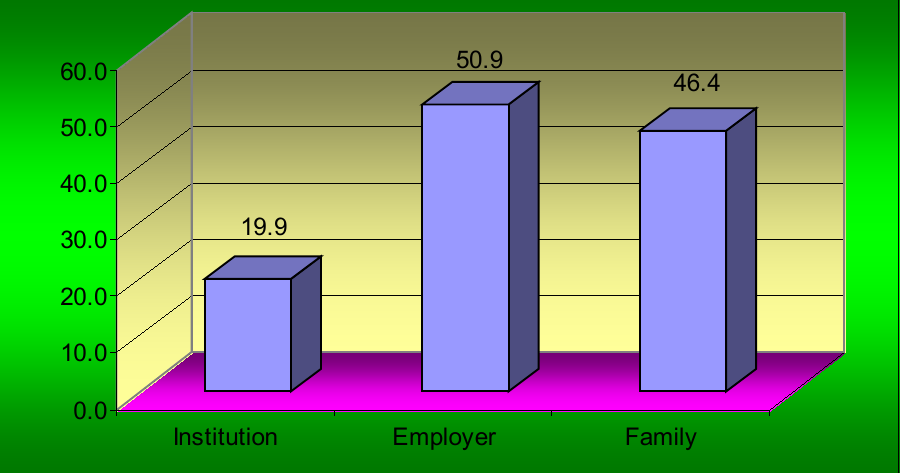
Figure 2. Who pays the cost of using the Internet?